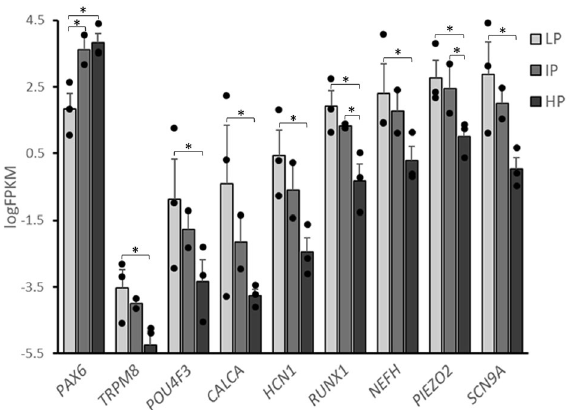
Figure 3. Comparison of average expression levels of neuronal marker genes at day 33 post-induction in three iPSC-dSN lines induced at three different iPSC passage numbers. LP = low-passage, IP = intermediate-passage, HP = high-passage; * FDR < 0.05.